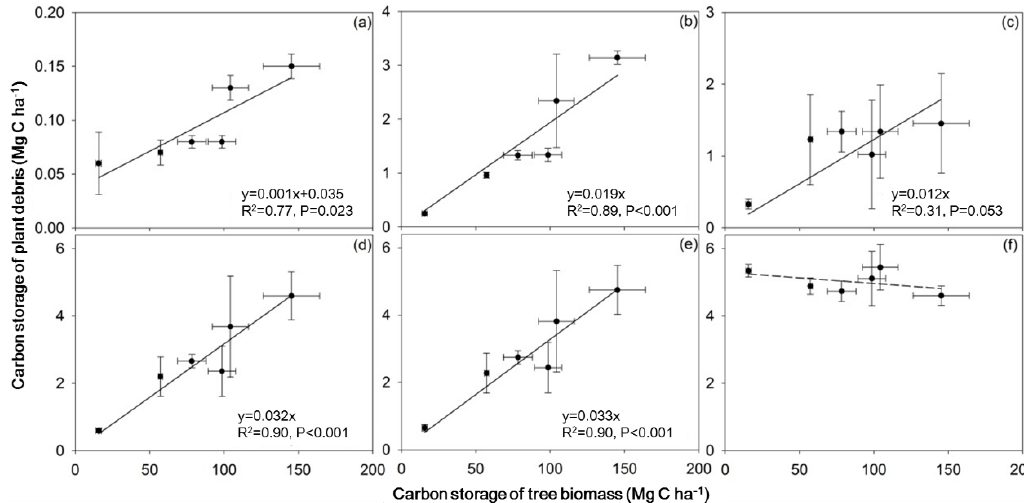
Figure 4. Relationships between carbon storage in plant debris and in live tree biomass. ( a ) Fine woody debris; ( b ) fallen logs; ( c ) standing snags; ( d ) coarse woody debris; ( e ) woody debris; and ( f ) litter.